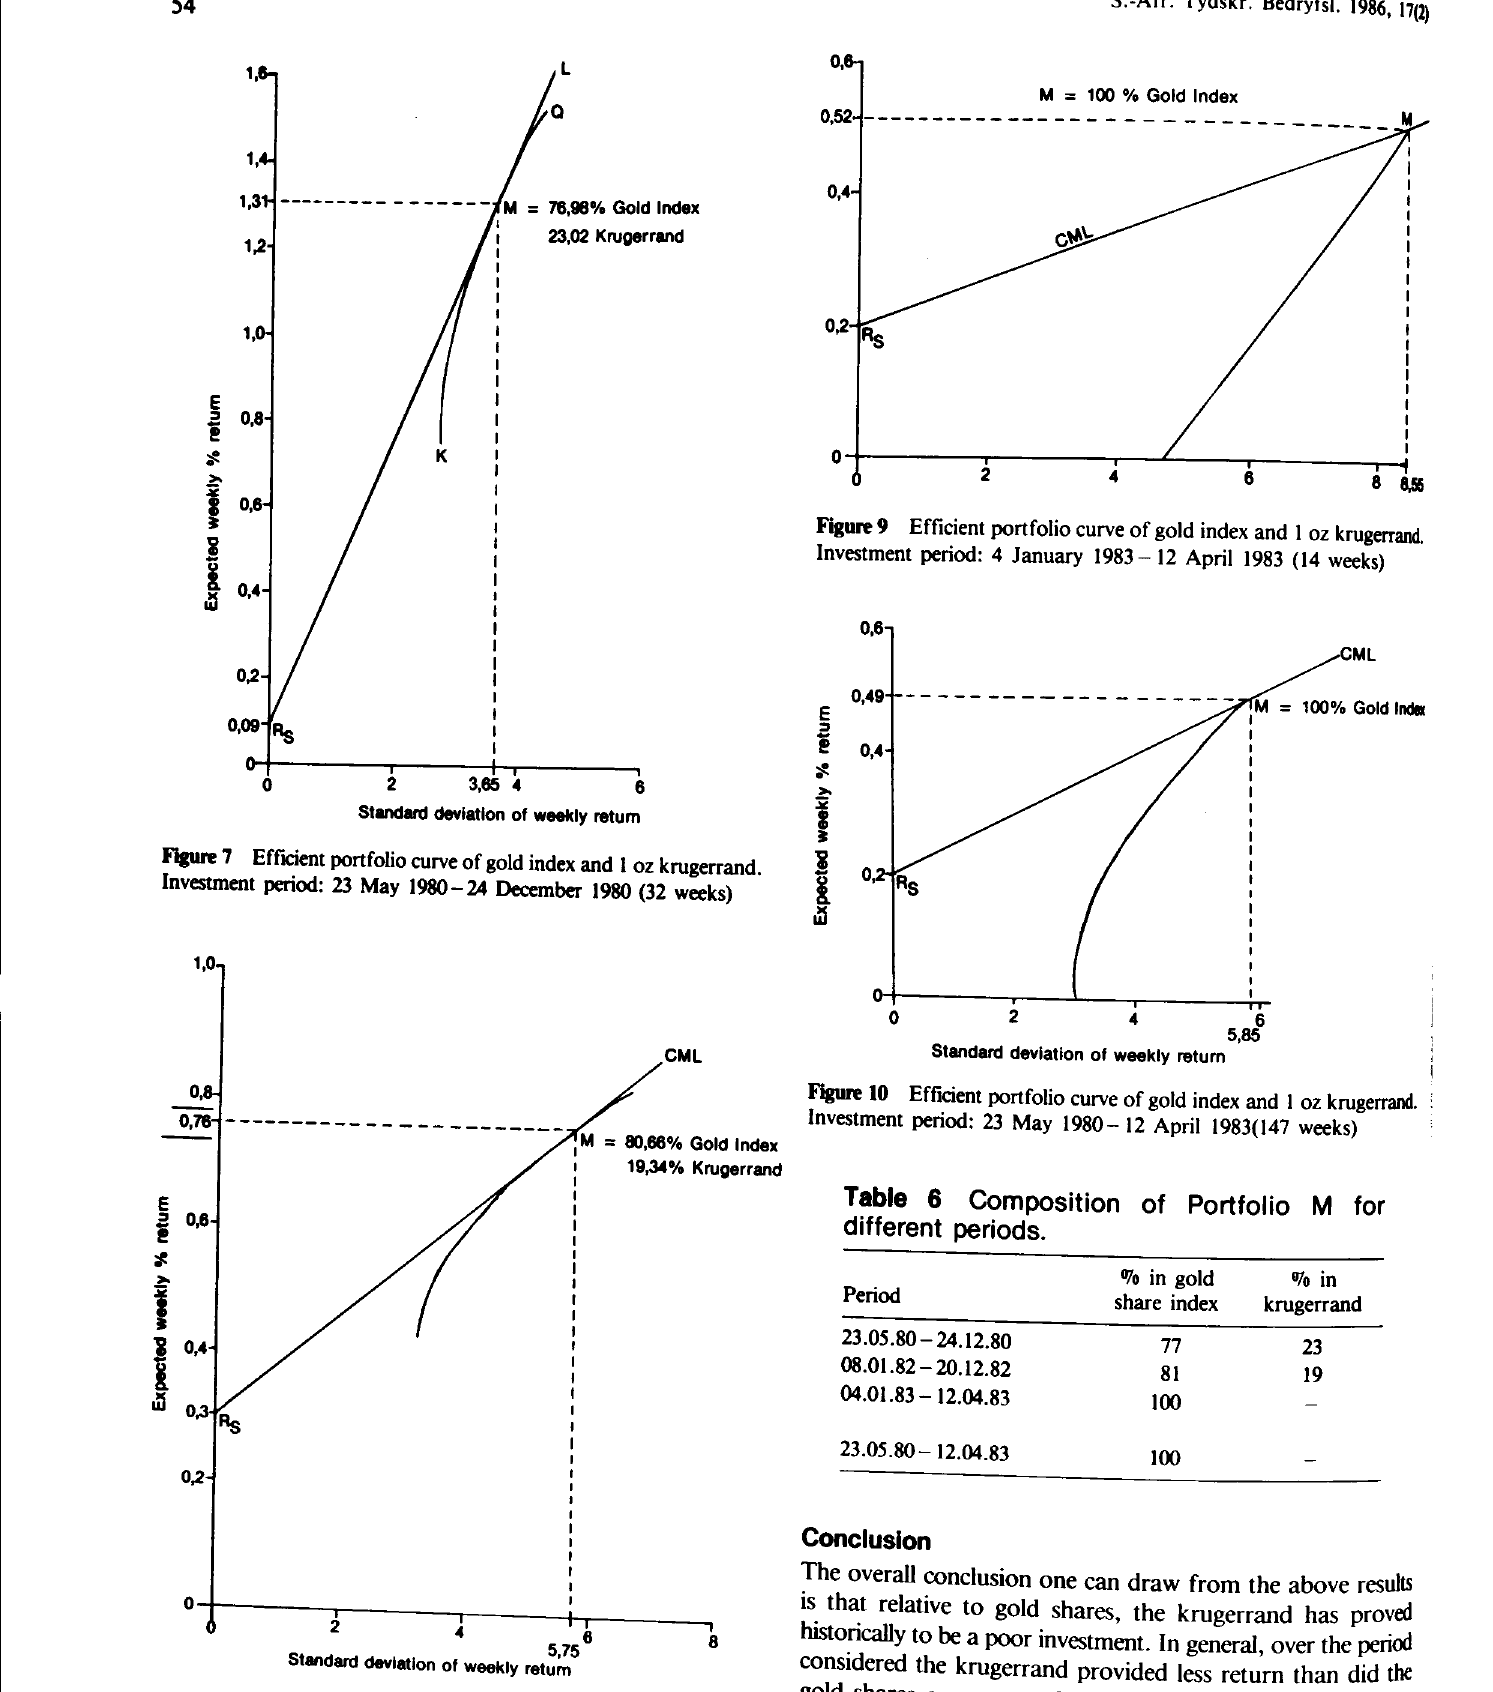
Composition of Portfolio M for different